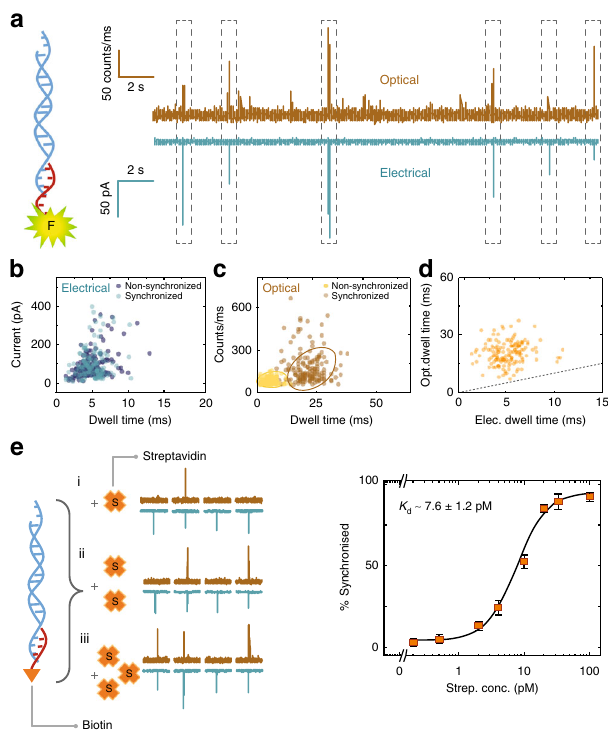
Fig. 3 Single-molecule and single- fl uorophore sensitivity. a Photon and current time traces for the translocation of λ -DNA carriers bound to fl uorescently labelled DNA oligonucleotides (5 ′ -AGGTCGCCGCCC GGTTGGGTGGGTTGG-Atto 488-3 ′ ) in 100 mM KCl, buffer (pH = 8). b Scatter plots for dwell time vs. current amplitude/intensity for both electrical and c optical measurements ( N = 178 non-synchronised, N = 152 synchronised). Data for both synchronised and non-synchronised events are shown. d Scatter plot showing synchronised optical vs. electrical dwell times. The dashed line has a slope equal to 1 and represents the ideal case of both optical and electrical events having the same dwell times. e A binding assay was demonstrated using a DNA carrier modi fi ed with a biotinylated oligonucleotide which can then bind to streptavidin. Translocation experiments were performed at − 300 mV bias in 100 mM KCl buffer (pH = 8). A fi nal DNA carrier concentration of 10 pM was used and incubated with Dylight 488-conjugated streptavidin at varying concentrations at room temperature. Error bars indicate the standard deviation for data obtained from three different nanopipettes. In all cases, the laser power was 198 ± 6 μ